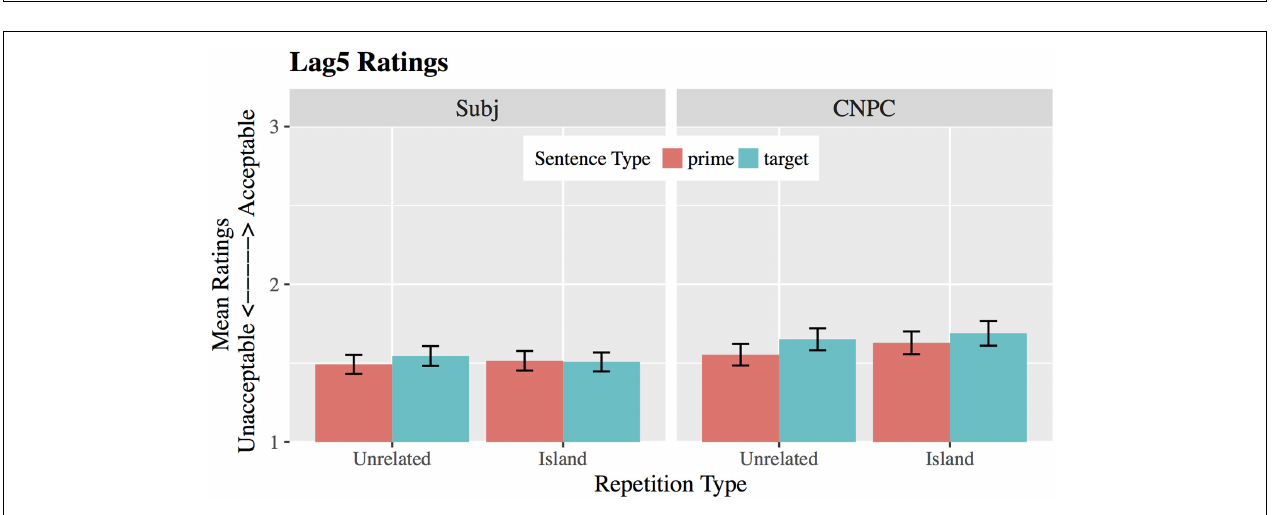
FIGURE 2 | Mean ratings for CNPC and Subject islands in Lag5. Raw scores are presented on a 5-point scale, where 1 = Completely Unacceptable and 5 = Completely Acceptable. Error bars represent ± 1 standard error. For visibility, we show only 1–3 points on the